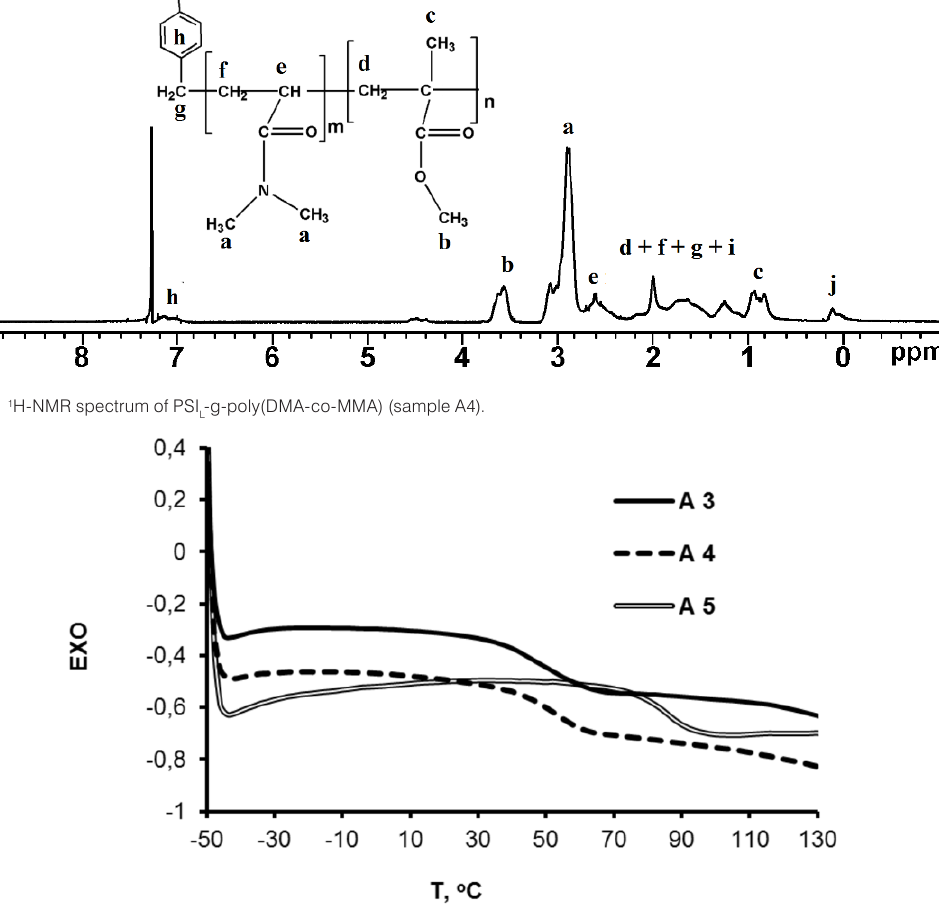
Figure 2. DSC curves of linear and cyclic polysiloxanes grafted with poly(DMA-co-MMA).